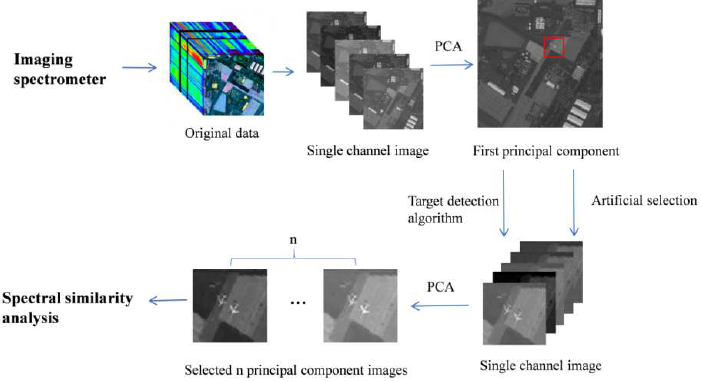
Figure 5. Target recognition process based on dimension reduction analysis of the hyperspectral image region.